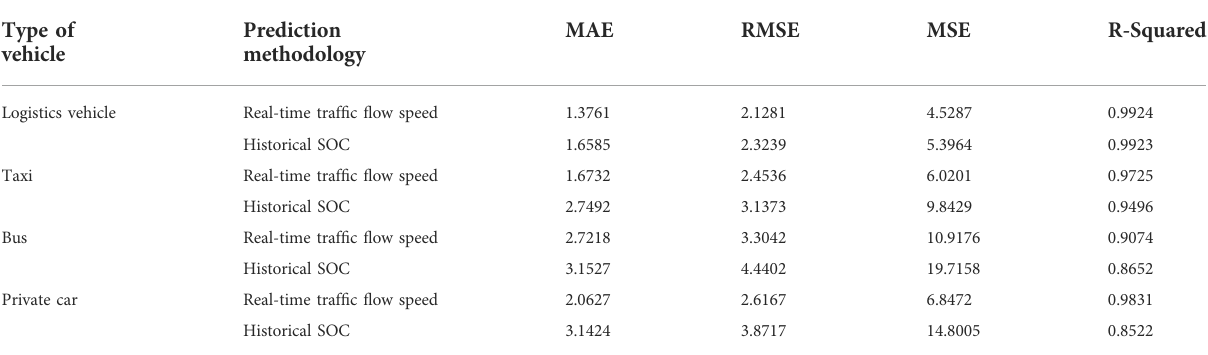
TABLE 4 Evaluation